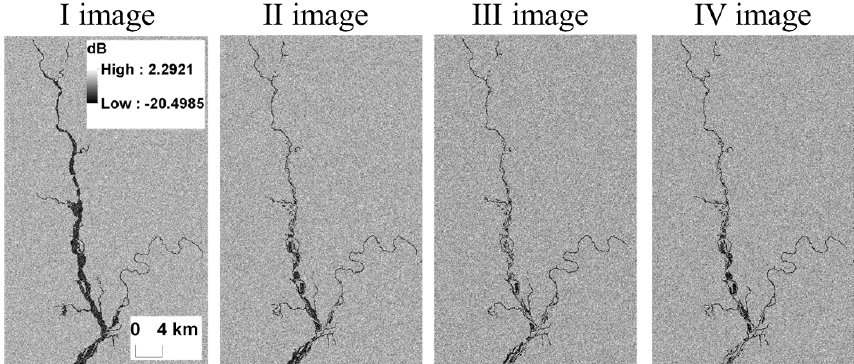
Figure 3. Detail of the synthetic SAR images corresponding to the four assimilation time steps. Darker pixels correspond to lower backscatter.